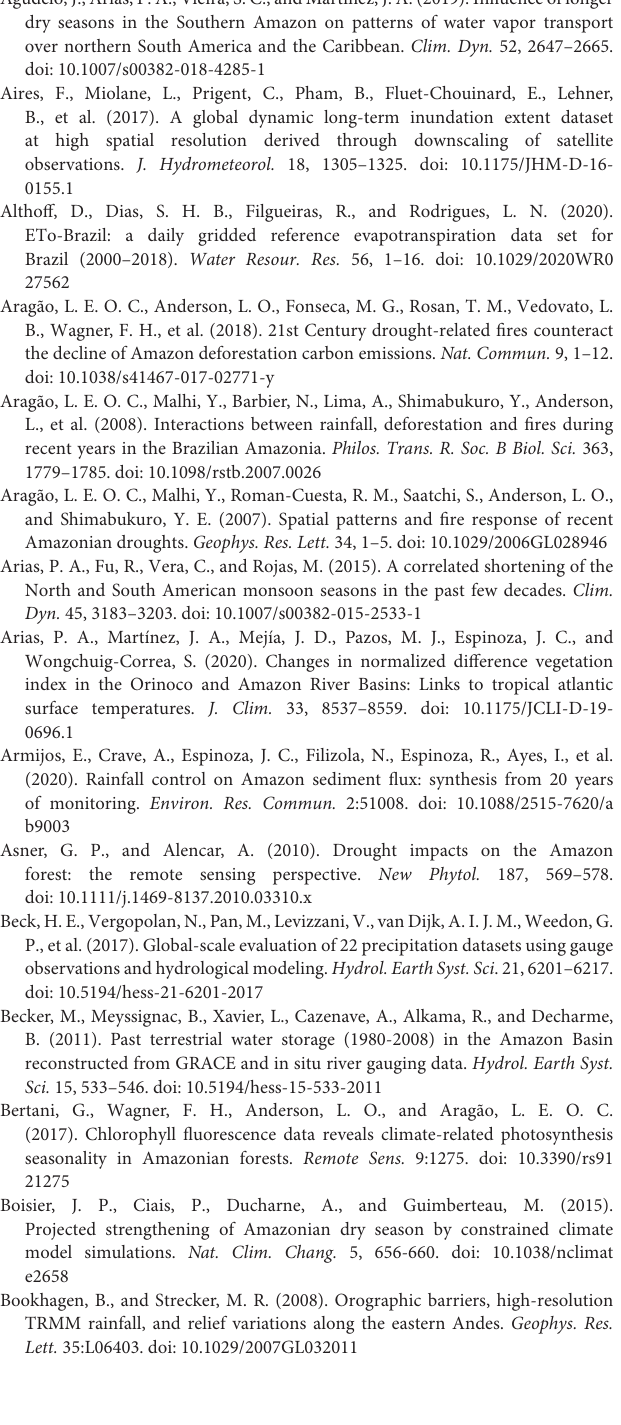
Supplementary Figure 4 | NDVI anomalies during the drought years of (A) 2007, (B) 2010, and (C) 2011. The anomalies are calculated for the VDS. The percentage of the area with negative anomalies below one standard deviation in the predominant land cover types is